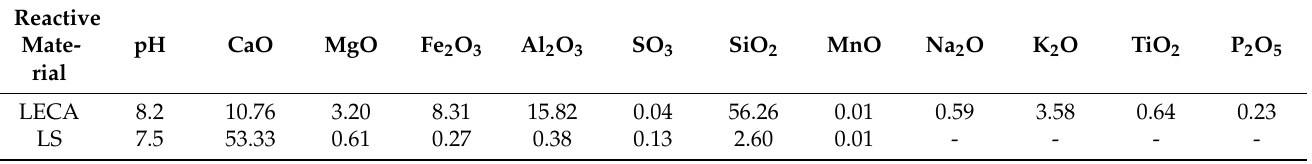
Table 1. The pH and compositions of the reactive materials (%) (manufacturer data) (LS: limestone and LECA: lightweight expanded clay